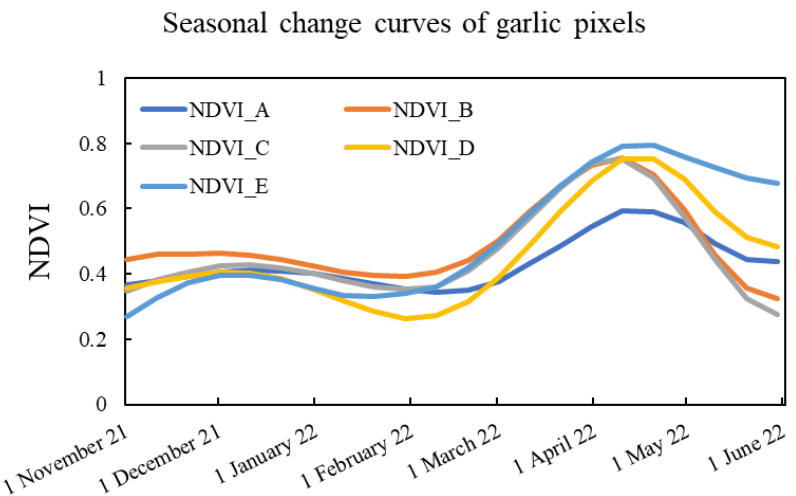
Figure 7. Seasonal changes of NDVI for garlic in different regions. Among them, NDVI_A, NDVI_B, NDVI_C, NDVI_D, and NDVI_E are the garlic fields in Zhengzhou, Kaifeng, Jining, Linyi, and Xuzhou, respectively.